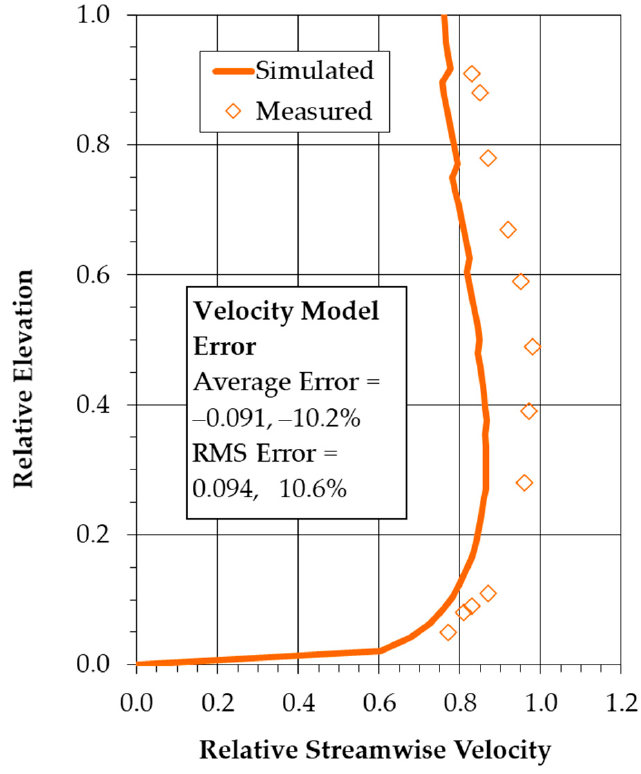
Figure 12. Comparison of simulated and measured velocity profile at cross-section S0 at position + 0.307 B.